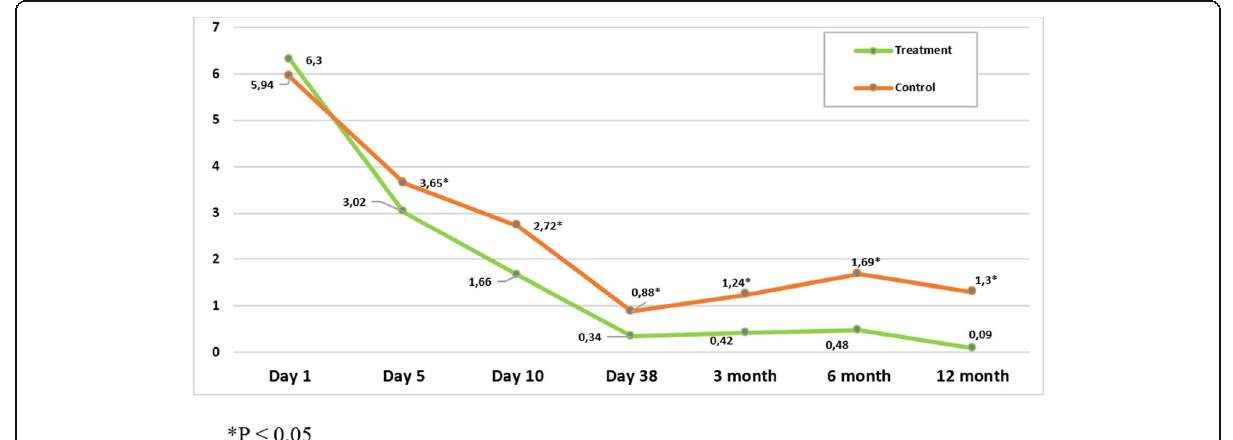
Fig. 3 Dynamics of the indicator “ Patient self-assessment ”